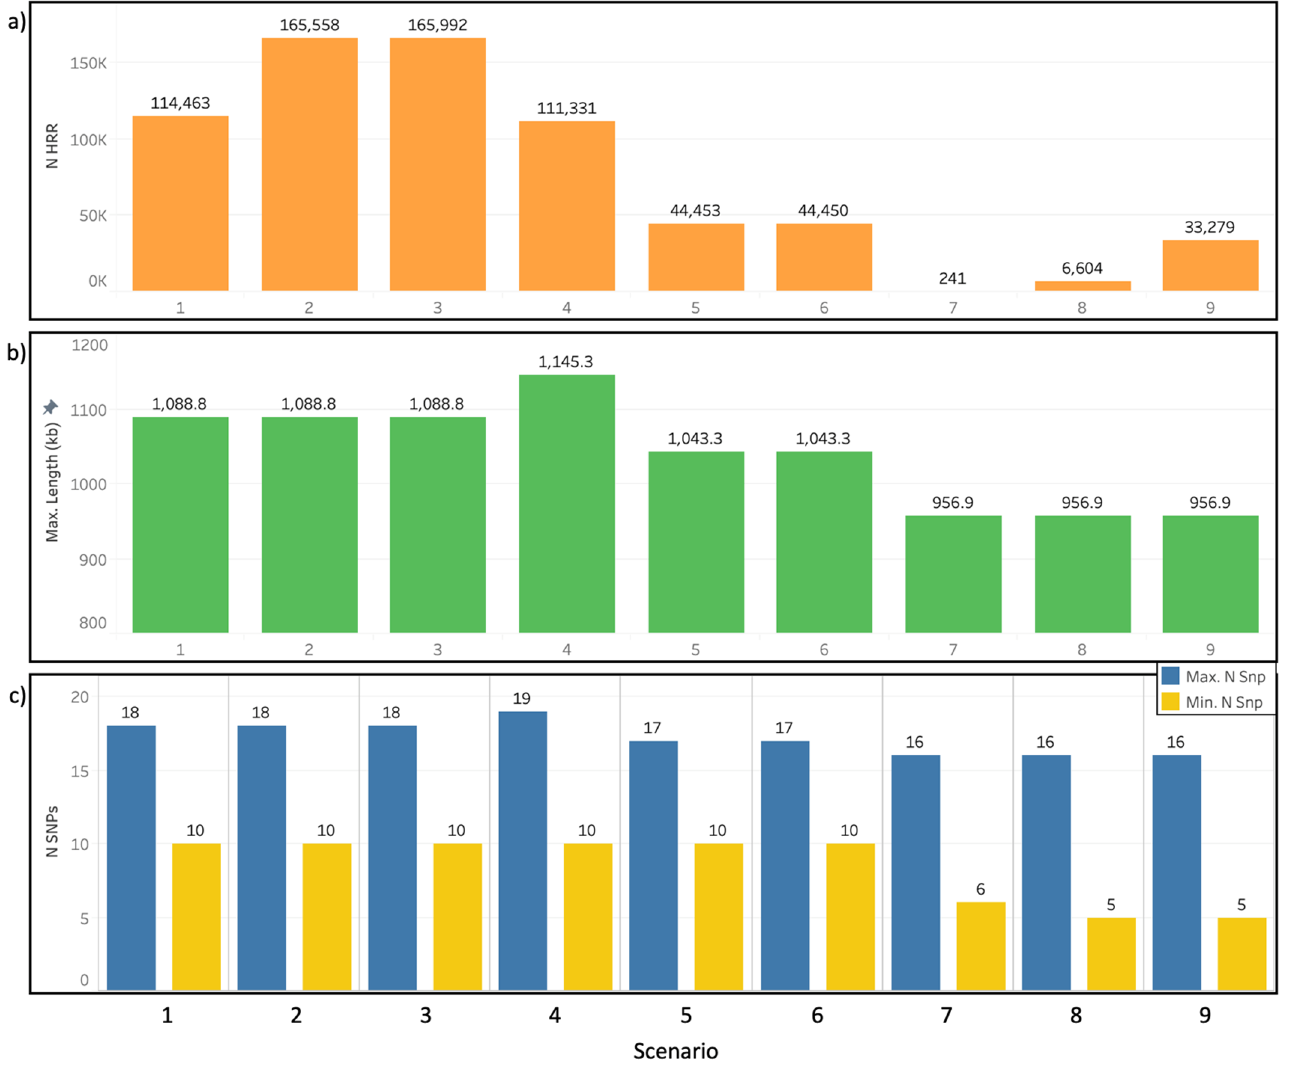
Figure 4. Number of heterozygosity-rich regions (HRRs) ( a ), maximum length of HRR ( b ), and maximum and minimum number of SNPs in an HRR ( c ) across nine scenarios of HRR detection, applied in a dataset of seventeen worldwide sheep populations.